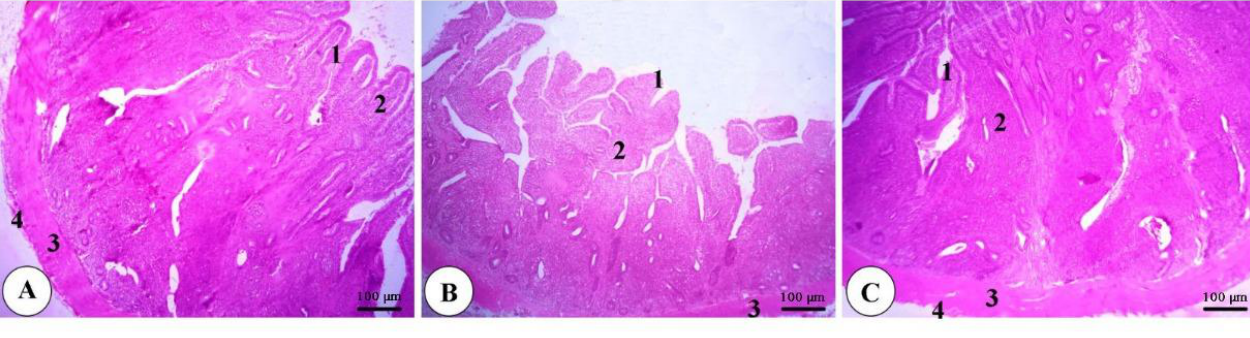
Figure 3. Representative photomicrograph of the cecum of a broiler of the dry feed ( A ), wet feed ( B ) and fermented wet feed ( C ) groups showing the simple columnar epithelium of the tunica mucosa (1), lamina propria with extensive deposits of lymphatic cells (2), tunica muscularis (3) and tunica serosa (4). H&E, bar = 100 µm. ( n = 8).